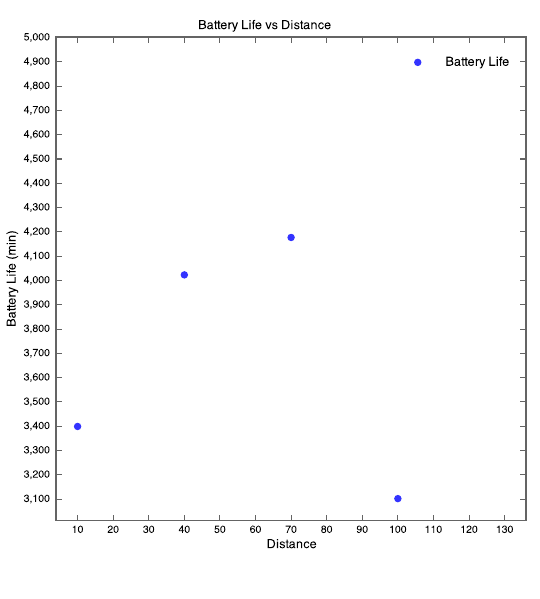
Figure 8. Battery lifetime for Experiment